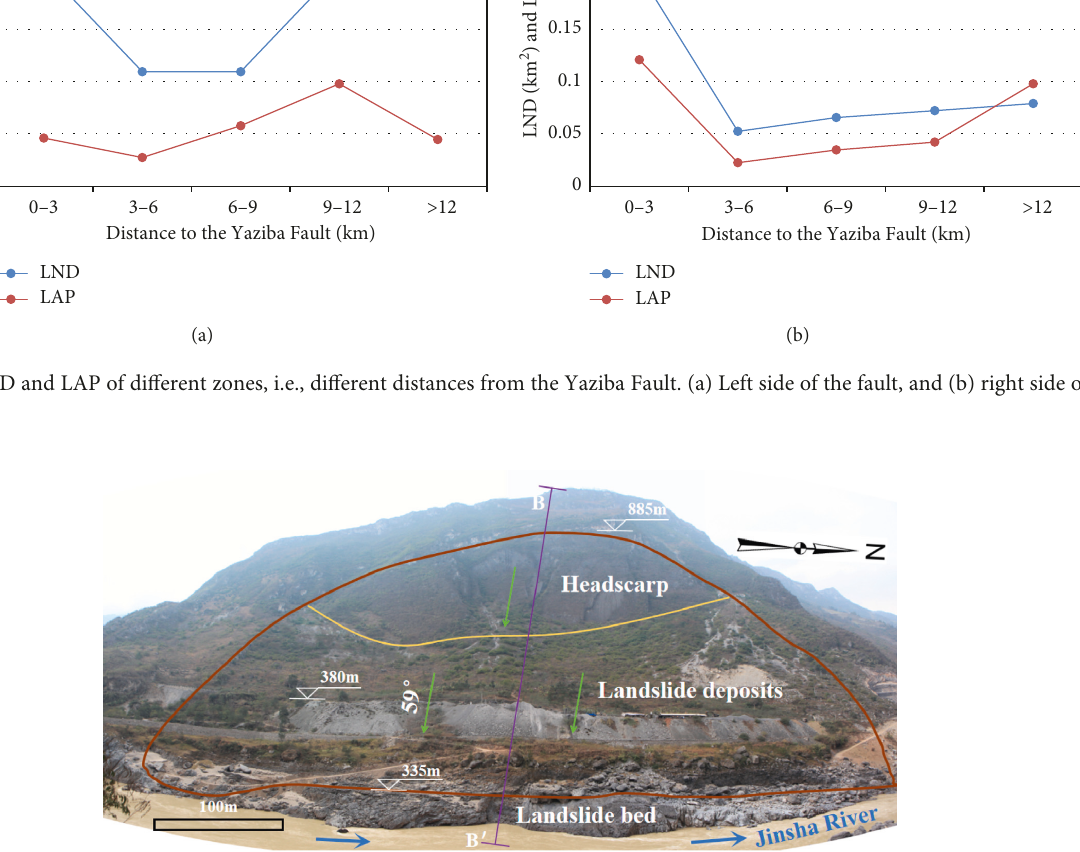
Figure 10: Panoramic view of the Daomakan landslide.